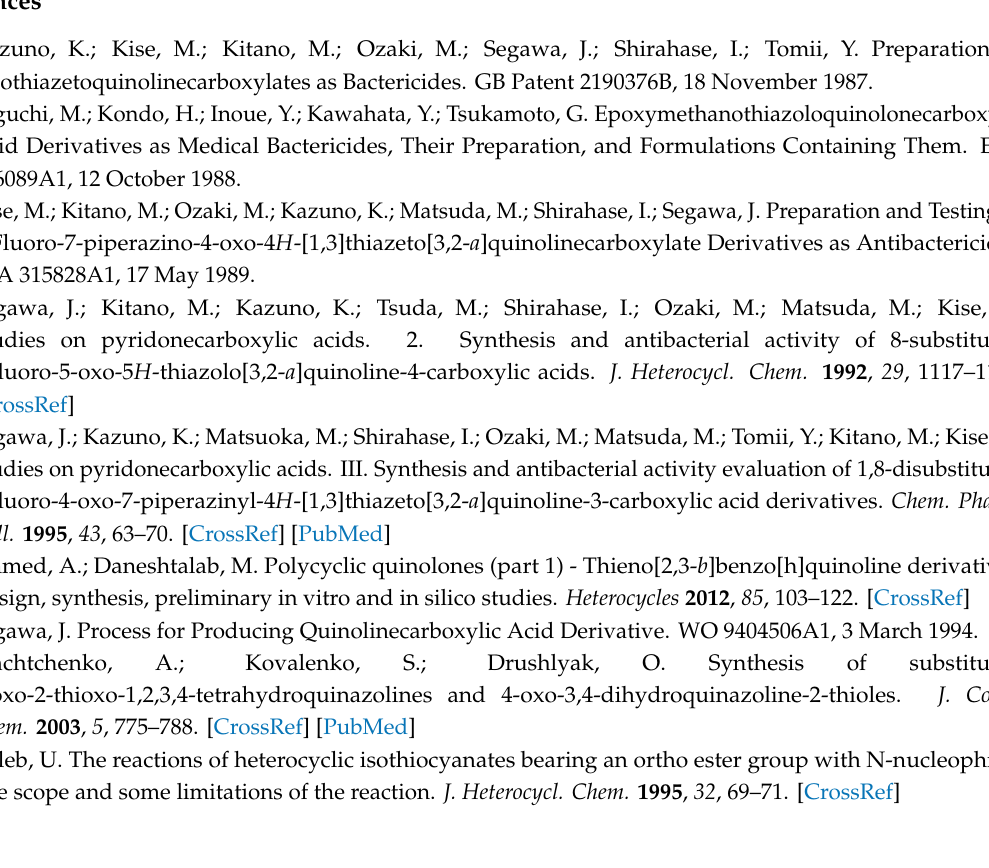
Figure 3. Molecular structure of compound 14 according to X-ray diffraction data. Thermal displacementellipsoids are shown at the 50% probability level.